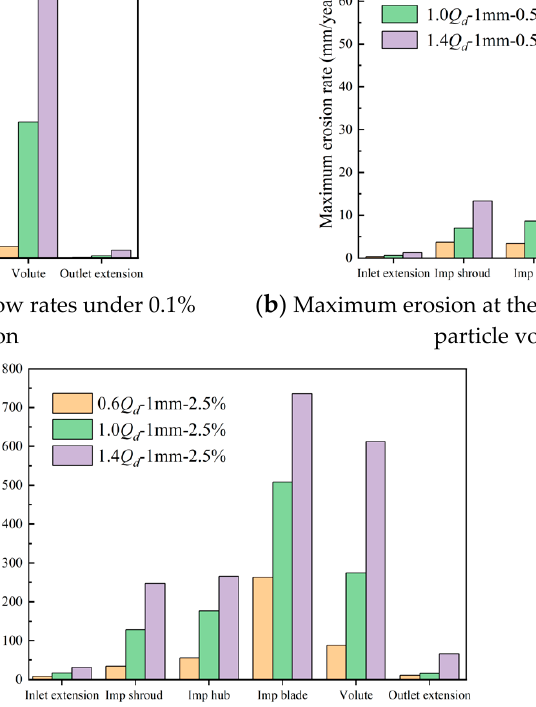
Figure 10. Maximum erosion rates on different components of the pump under different working flow rates and particle volume fractions. ( a ) Maximum erosion at the different flow rates under 0.1% particle volume fraction; ( b ) Maximum erosion at the different flow rates under 0.5% particle volume fraction; ( c ) Maximum erosion at the different flow rates under 2.5% particle volume fraction.